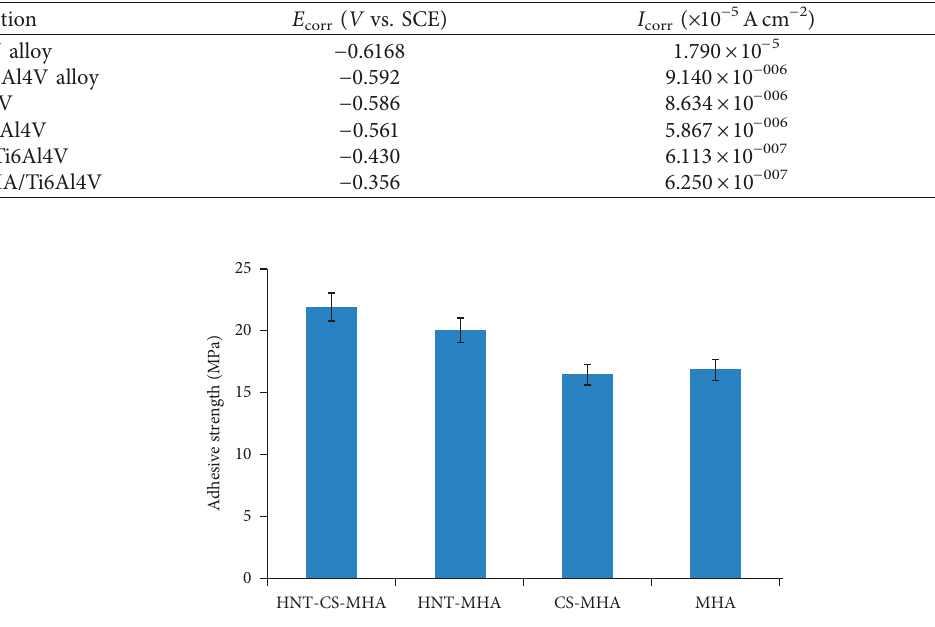
Figure 5: Adhesive strength of coated Ti6Al4V alloy.